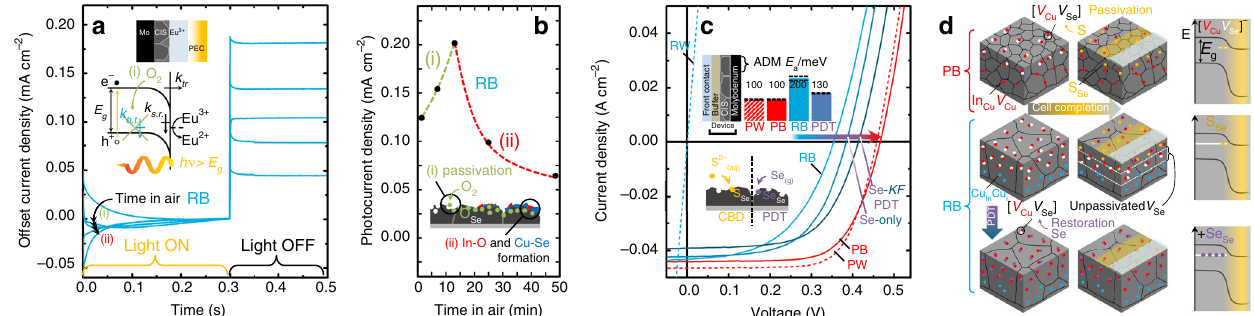
Fig. 7 Chemical identi fi cation/passivation of the CuInSe 2 metastable defects and impact on PV device performance. a PEC transients of Cu-rich CIS subject to bold KCN etch (RB) after repeated exposure to air at room temperature (note that illumination starts at time 0 and, for discussion purposes, the curves have been y -shifted such that the steady-state current densities under illumination coincide). b Evolution of the photocurrent density J Ph as a function of air-exposure time, revealing an initial regime of photocurrent increase (i) exempli fi ed in the schematics by O 2 -induced passivation of V Se donors and corresponding removal of the bulk trap recombination pathway, followed by a subsequent decrease (ii), due to the detrimental formation of Cu-Se an In-O at the CIS surface. c JV characteristics of solar cell devices comprising Cu-poor (P, red) and Cu-rich (R, blue) CIS absorbers subject to weak KCN (W, dashed) and bold KCN (B, solid) etching. The V oc improvement obtained with CIS-RB fi lms upon Se-only and Se-KF PDTs is shown by the arrow. The bar chart refers to the corresponding activation energies of the main capacitance step extracted from thermal admittance spectroscopy (see Supplementary Figs. 7 and 8). d Proposed schematic illustration of point defect distribution in Cu-poor and Cu-rich fi lms after bold KCN etching (PB and RB), showing the different extent of Cu and Se depletion leading to the formation of [V Cu V Se ] divacancy complexes. The divacancy complex occurs near the surface of CIS- PB but extends deeper in the bulk of CIS-RB. The deposition of CdS by chemical bath close to room temperature (solar cell completion) induces S incorporation into V Se , i.e., dissolution of the complex. The S incorporation is suf fi cient to passivate the corresponding electronic states present at the surface of PB fi lm but is insuf fi cient to reach deeper in the RB fi lm; hence, some of the defect complexes remain. Post-deposition treatments with Se at high temperature prior to cell completion enable a more effective replenishment of the Se vacancies, with a bene fi cial passivating effect that increases the V OC of the photovoltaic